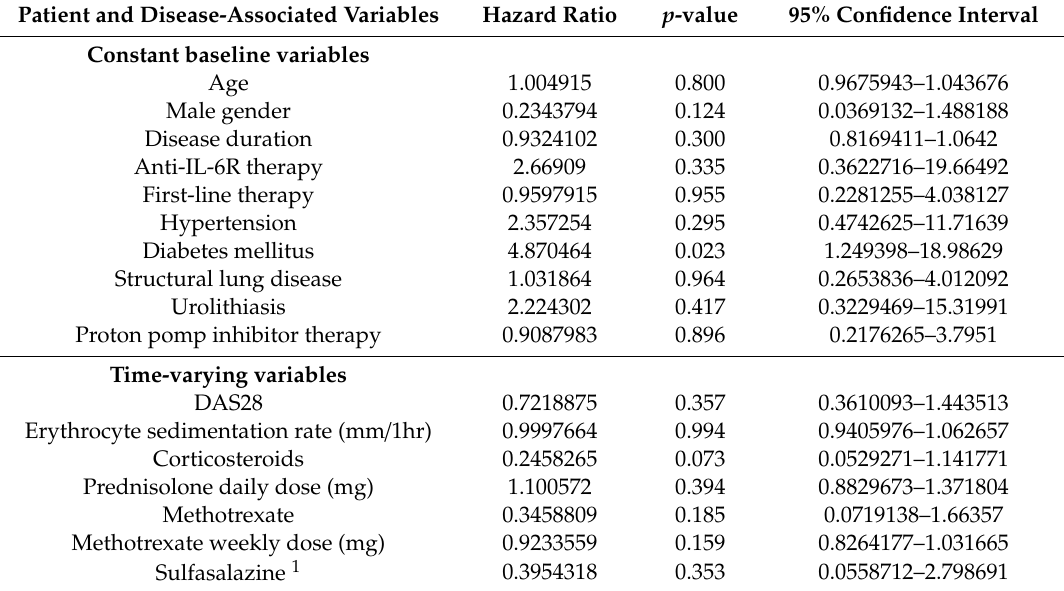
Table 4. Univariate survival analysis